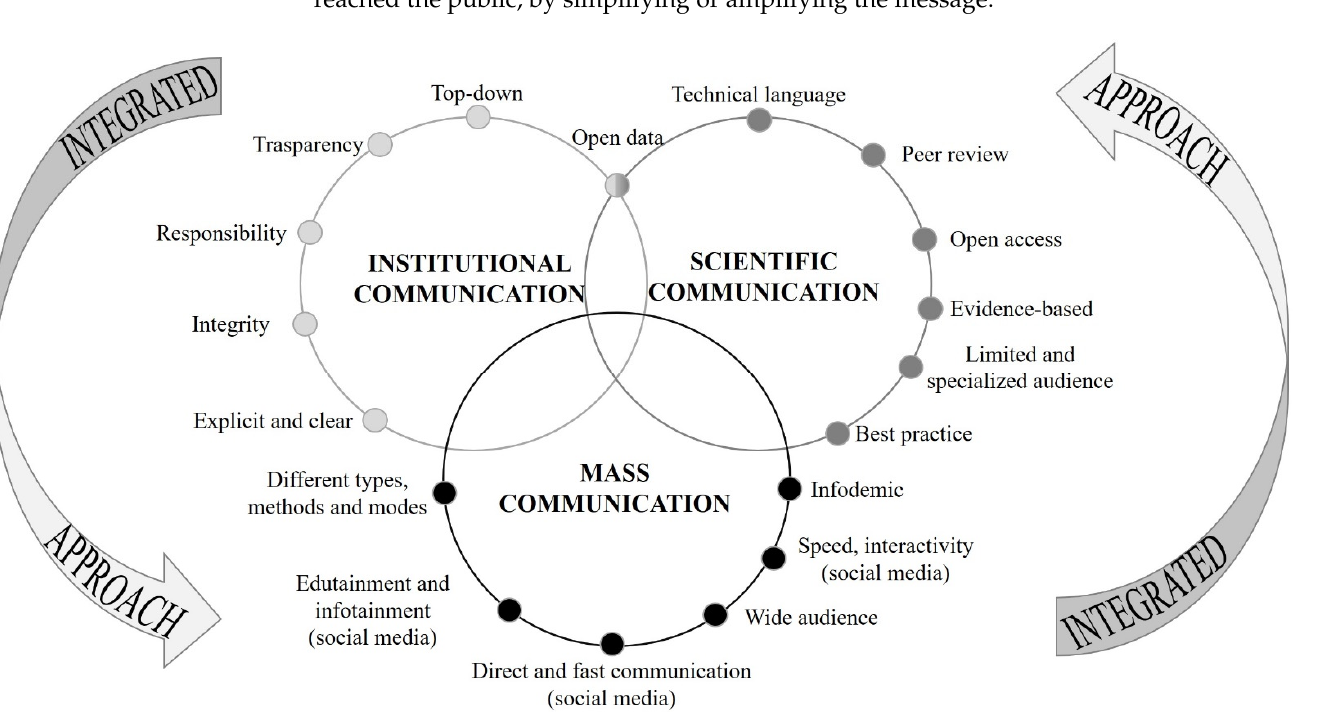
Figure 1. Intersection of institutional, scientific and mass